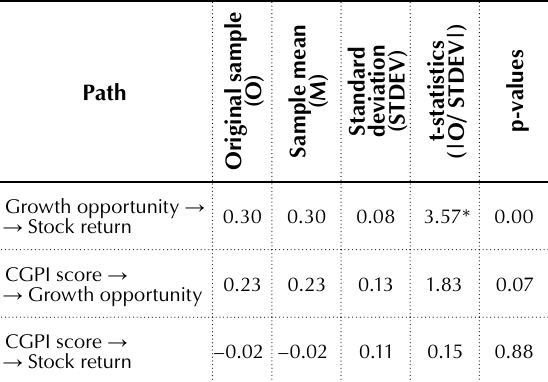
Table 2. Inner model PLS testing result